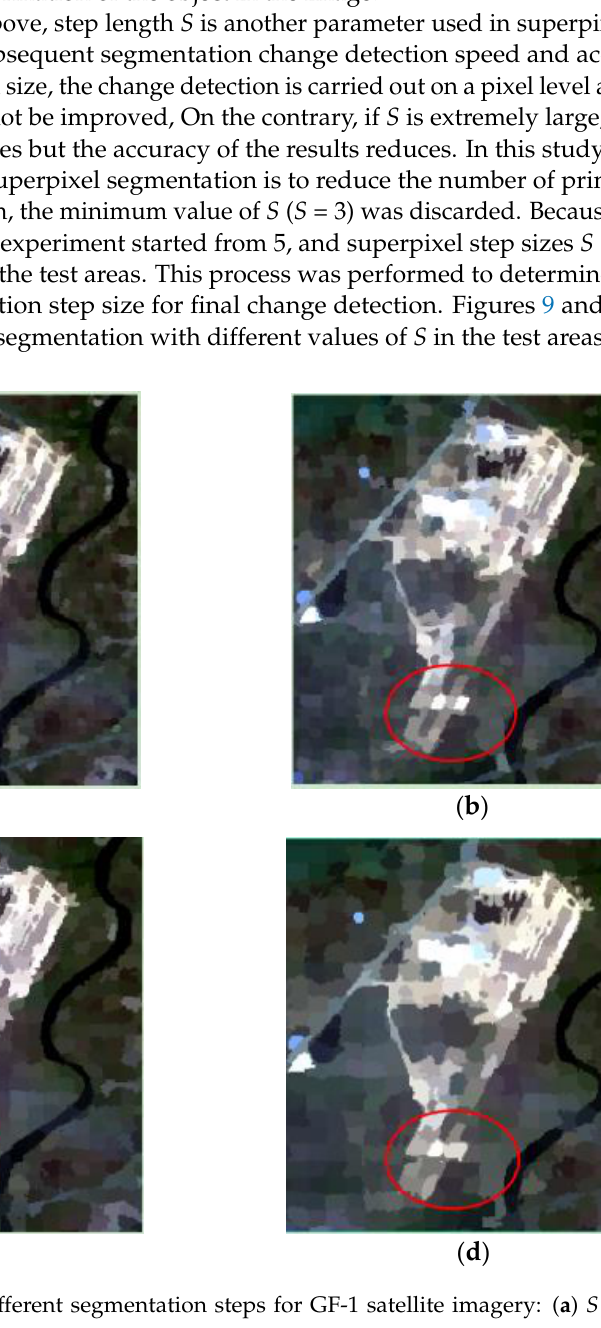
Figure 8. Results of different compactness parameters for Landsat satellite imagery: ( a ) m = 10; ( b ) m = 20; ( c ) m = 30; ( d ) m = 40.